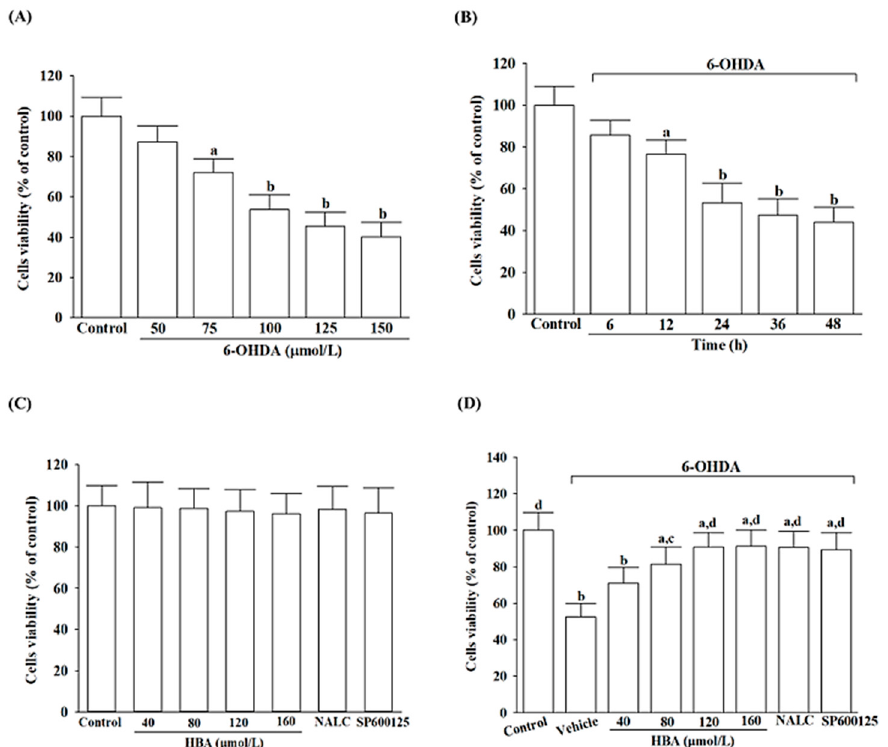
Figure 1. HBA rescues SH-SY5Y cells from the neurotoxicity induced by 6-OHDA. ( A ) Cell viability was assessed for various concentrations of 6-OHDA that were incubated with SH-SY5Y cells over a 24 h period. ( B ) Cell viability was evaluated for SH-SY5Y cells incubated with 100 µ mol/L 6-OHDA for a period. ( C ) Cell viability was evaluated when SH-SY5Y cells were incubated with various concentrations of HBA, 1 mmol/L NALC, or 10 µ mol/L SP600125 for 24 h without exposure to 100 µ mol/L 6-OHDA. ( D ) Cell viability was evaluated when SH-SY5Y cells were pretreated with different concentrations of HBA, 1 mmol/L NALC, or 10 µ mol/L SP600125 for 1 h and then exposed to 100 µ mol/L of 6-OHDA for another 24 h. Cell viability was determined with an MTT assay and expressed as a percentage of untreated cells, considering the control group. The results are shown as the mean ± SD of five independent experiments ( n = 5) performed in triplicate. a p < 0.05 and b p < 0.01 compared to the data from untreated control group (control); c p < 0.05 and d p < 0.01 compared to the data from cells exposed to 6-OHDA with no treatment.